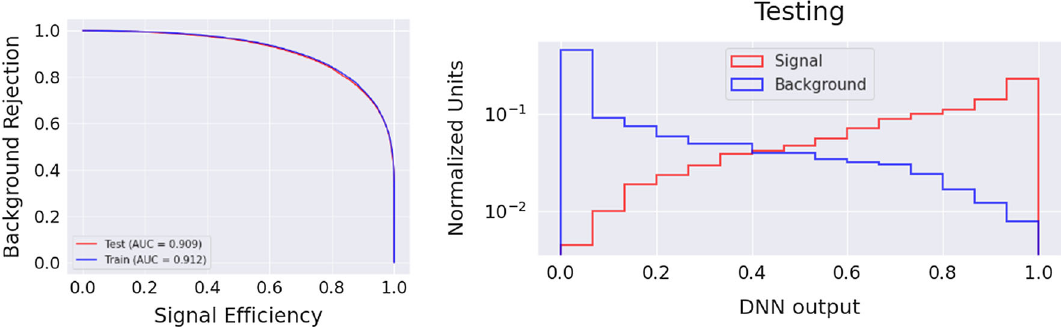
Fig. 10 Left panel: the ROC curve. Right panel: the DNN output which is used to discriminate the signal and background events